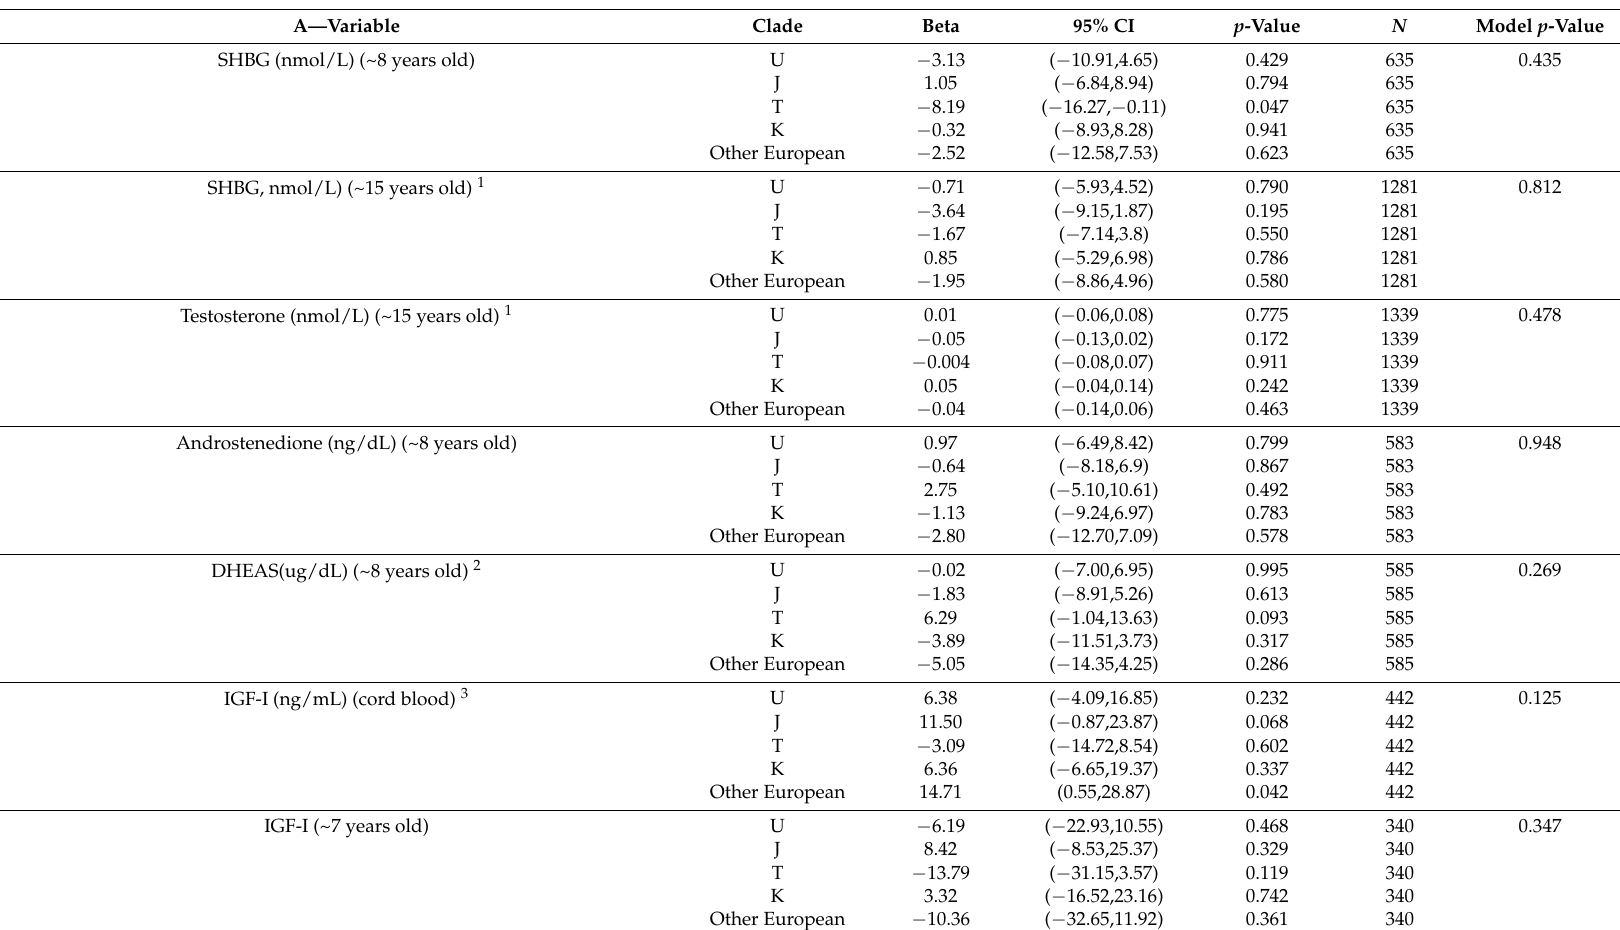
Table 3. Major European mtDNA haplogroups and breast cancer risk factors in ALSPAC children. Regression models adjusted for age, sex and the top 10